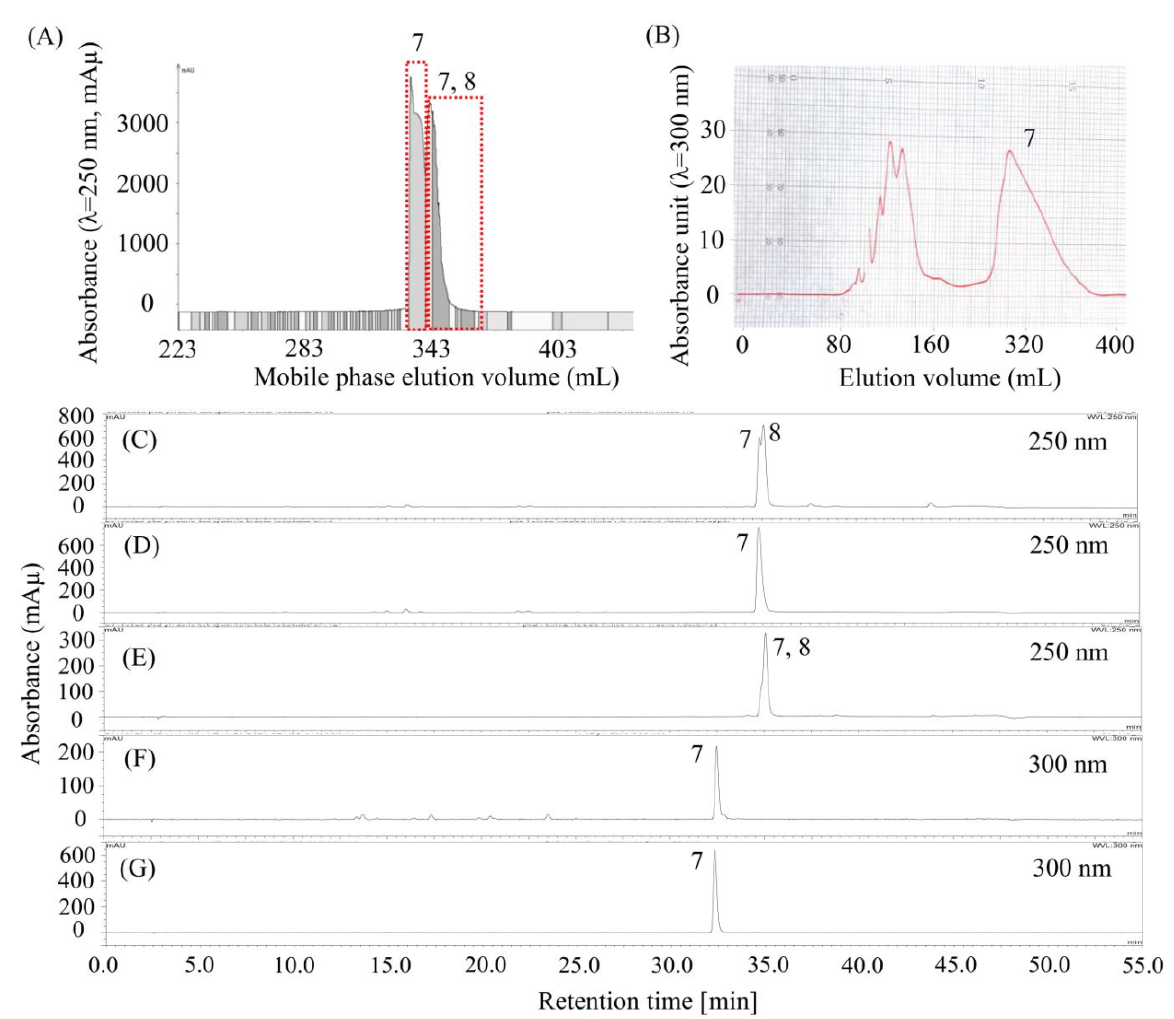
Figure 5. Chromatograms of pH-zone refining CCC, preparative HPLC, and analytical HPLC for the separation and purification of compound 7 . ( A ) Separation of compound 7 by pH-zone refining CCC from the mixture of 7 and 8 ( C ); ( D , E ) pH-zone refining CCC fractions of 7 ( D ), and a mixture of 7 and 8 ( E ); ( B ) preparative HPLC chromatogram for the purification of compound 7 from impure compound 7 ( F ); ( G ) purified 7 by preparative HPLC. Notably, chromatograms D and F were obtained from the same compound but analyzed using two different HPLC columns and monitored at different wavelengths. Moreover, compound 7 is later identified as